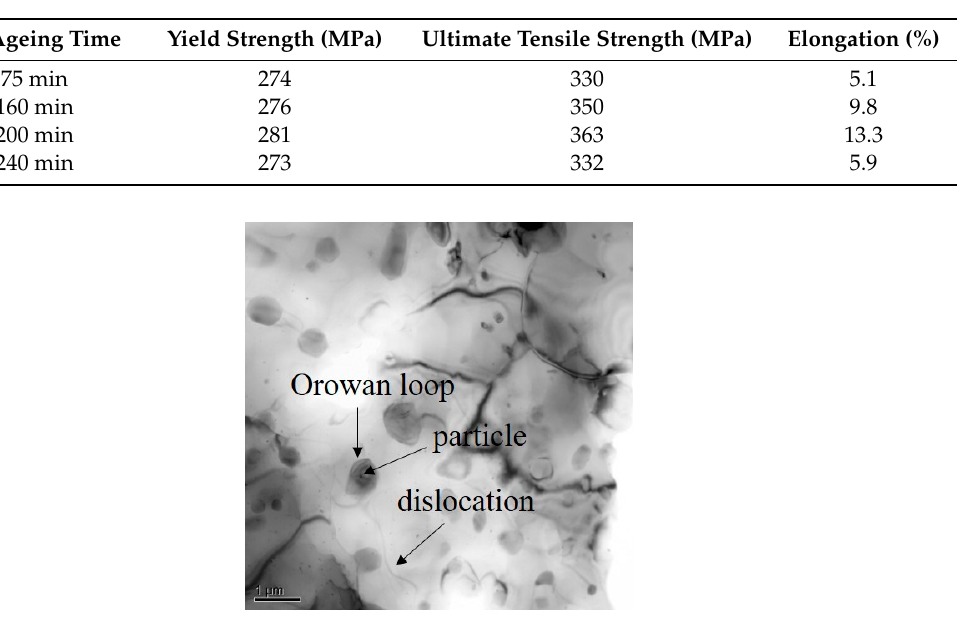
Figure 9. TEM image of the interaction of the second phase particles with dislocation in the rolled AZ80 magnesium alloy pre-aged for 200 min.